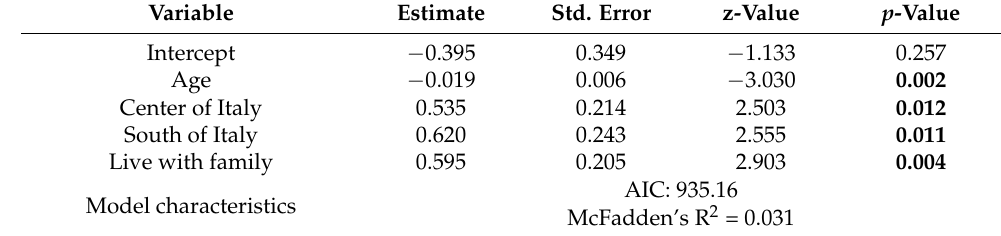
Table 5. The model estimation for probability of introducing cariogenic food during first lockdown.